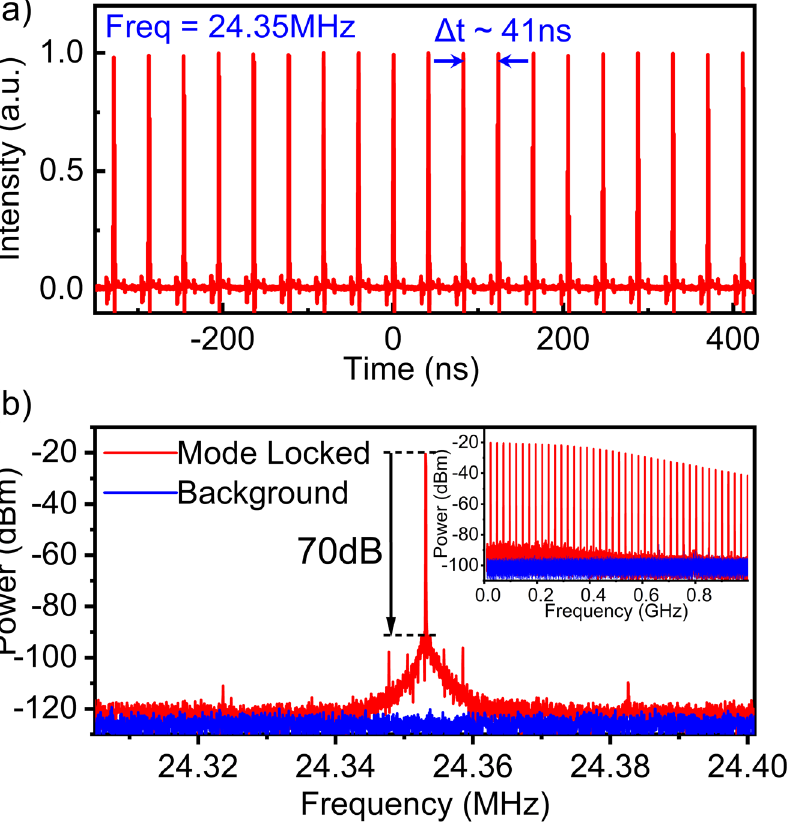
Figure4: (a)Measuredoutputpulsetrain.(b) Radio frequency spectrum with a RBW of 10Hz and a span of 200kHz at the fundamental frequency of 24.35MHz. Inset: RF spectrum with 1GHz